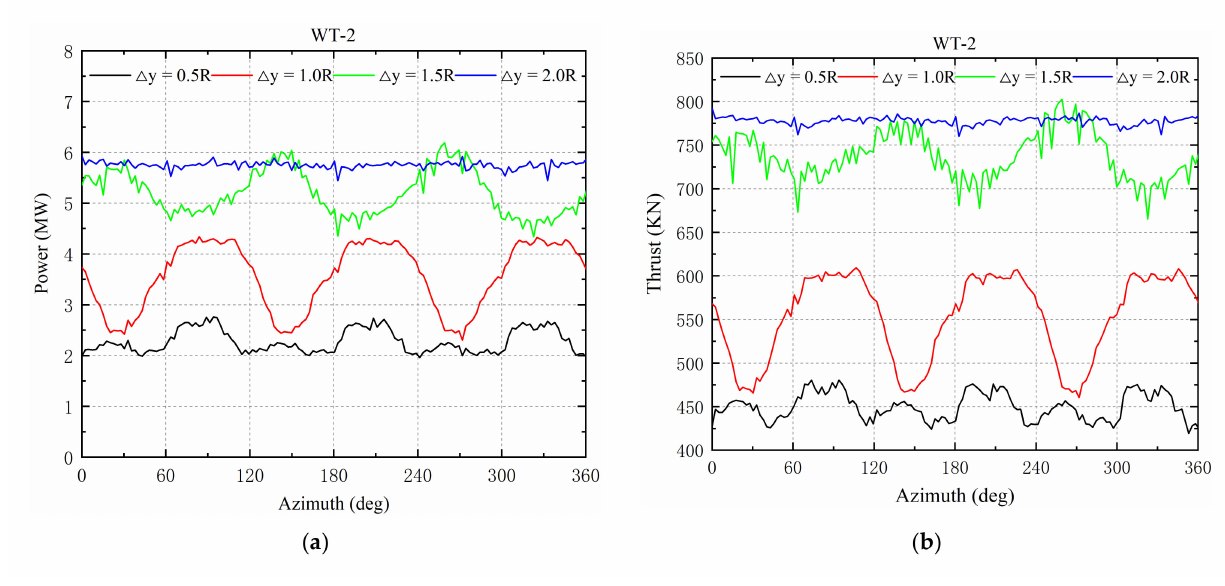
Figure 8. Profiles of the aerodynamic power and turbine thrust of WT-2 during the last calculated rotation (with blade 1 vertically upward). ( a ) The output of power; ( b ) Thrust.